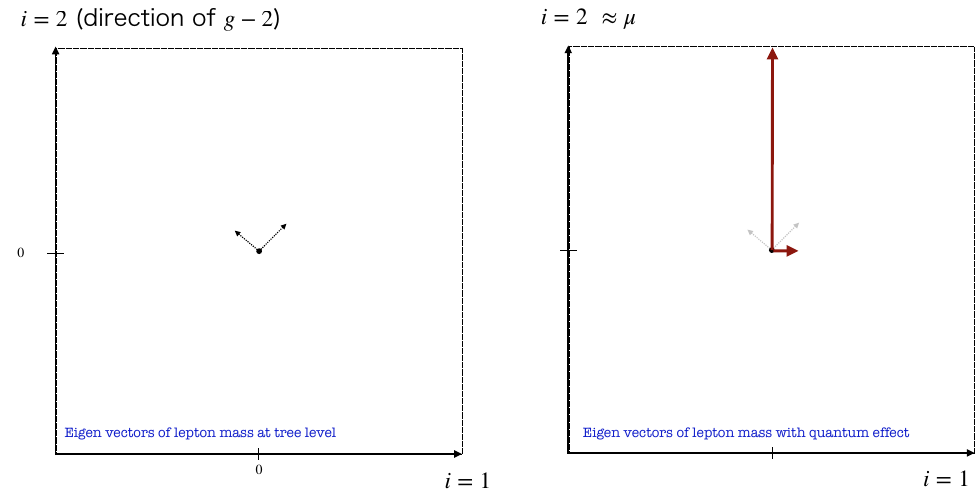
Figure 1 . The idea of the mass-interaction alignment mechanism is shown. We take the tree- level mass eigenvectors towards arbitrary directions in the flavor space (left panel). If the only one radiative induced mass, relevant to the g − 2 contribution, is dominant, the mass vector of the heavier lepton (the vertical red allow) is automatically aligned with the interaction vector of the “ g − 2 ” (along the y-axis) in flavor space as shown in the left panel. If the heavier mass vector is the muon and the lighter is the electron, the µ → eγ and the electron EDM are highly suppressed. The muon EDM may be generated which is a prediction of this